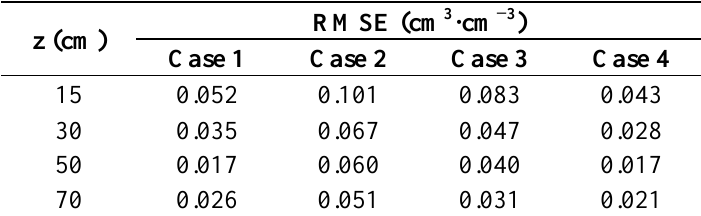
Table 5. RMSE between measured and simulated